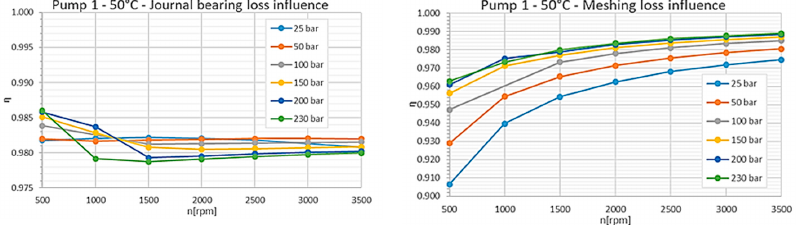
Figure 11. Figure 11. Cont.